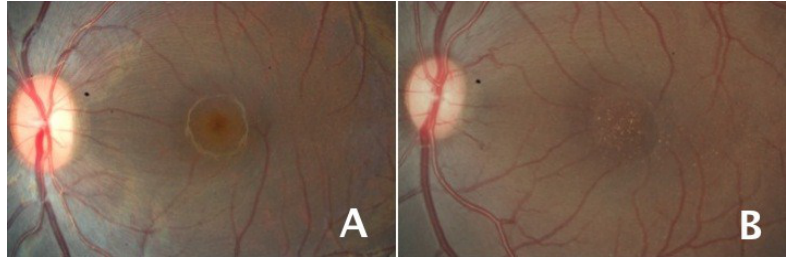
Figure 1. Visualization of macular pigment in two primate fovea. Retinal